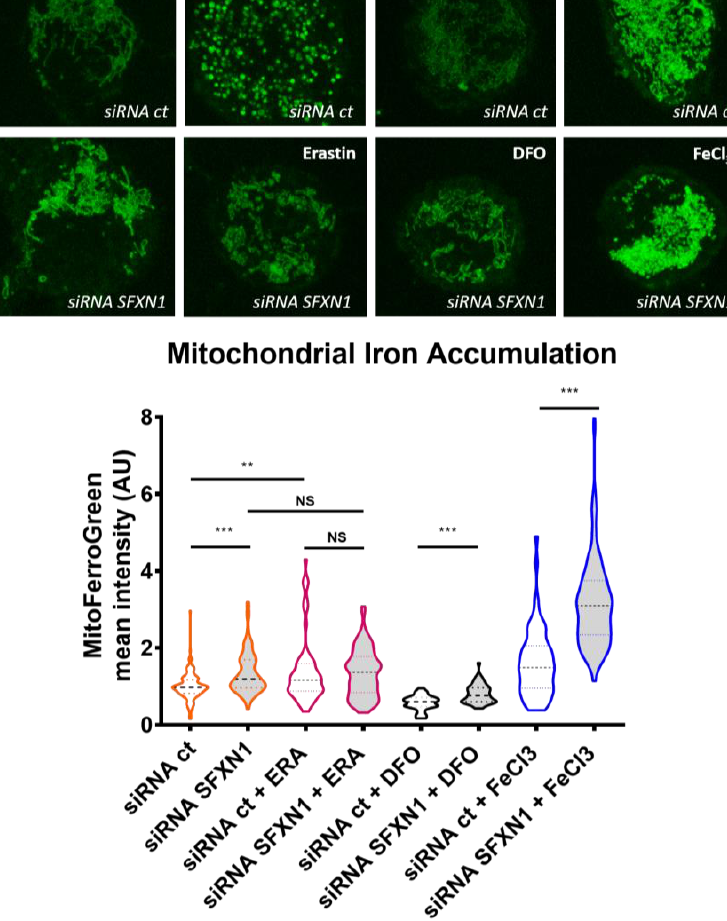
Figure 5. Depleting SFXN1 in HT1080 human cells leads to an intramitochondrial iron accumulation. Top panel: mitochondrial labile Fe(II) staining using the Mito-FerroGreen probe [70] after transient transfection with a control siRNA (siRNA ct) or a pool of SFXN1-targeting siRNA (siRNA SFXN1). Cells were further treated with DMSO (vehicle), erastin, DFO or FeCl 3 . Erastin is a drug that is widely used to trigger ferroptosis, DFO (deferoxamine) is an iron chelator that lowers mitochondrial iron levels and is used as a negative control. FeCl 3 increases intracellular iron levels and served as a positive control. SFXN1 depleted cells show higher mitochondrial iron levels than control cells (siRNA scramble transfected cells). Same magnification is used for all images and insets from full images taken at 630 × are shown here. Bottom panel: quantification of three independent assays ( n > 50 cells per condition) in which the fluorescent signal is measured and values are normalized to siRNA ct mean levels (mean = 1). After Mann-Whittney tests, significant differences are shown (** p < 0.01, *** p > 0.001, NS Not Significant). See Appendix A.2. for experimental